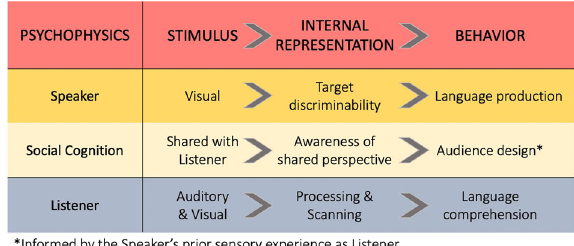
Fig. 2 The psychophysics of referential communication in a standard laboratory